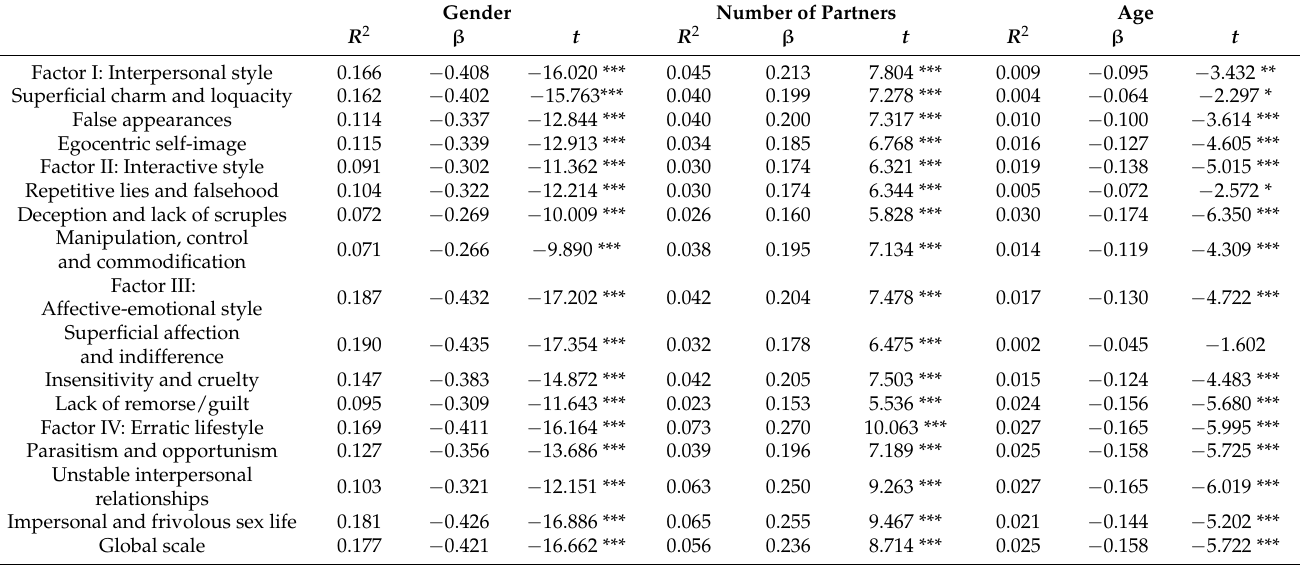
Table 4. Regression analysis between subclinical psychopathy with respect to gender, number of partners and